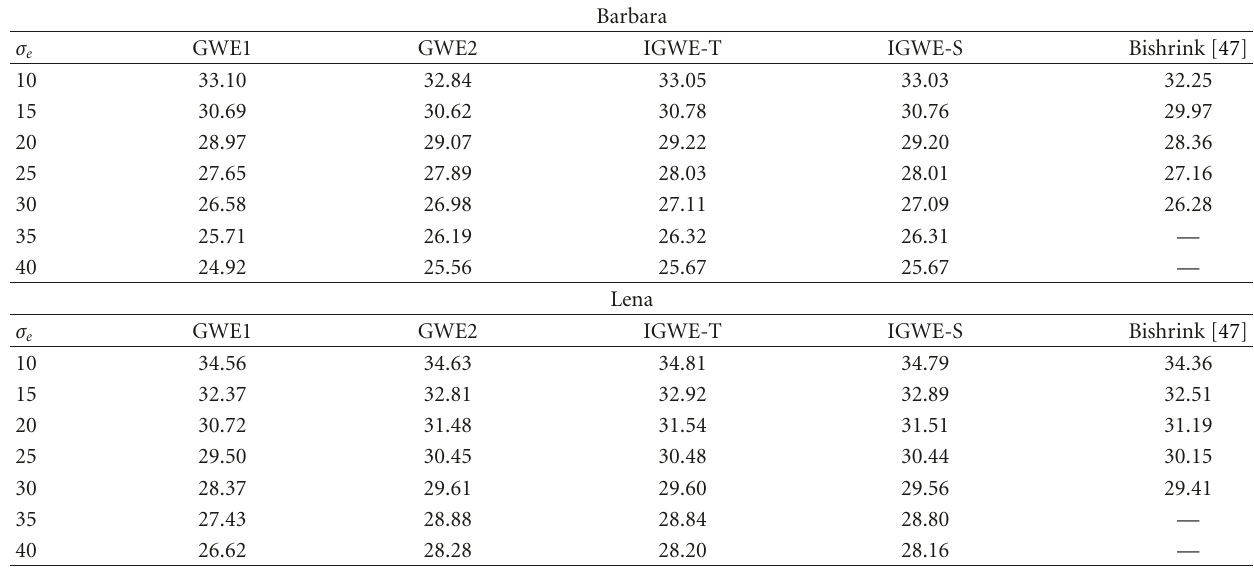
Table 3: PSNR (dB) results using two noisy images with di ff erent levels of additive noise. GWE1 and GWE2 are the GWE algorithms with √ 2, α = 1 and α =